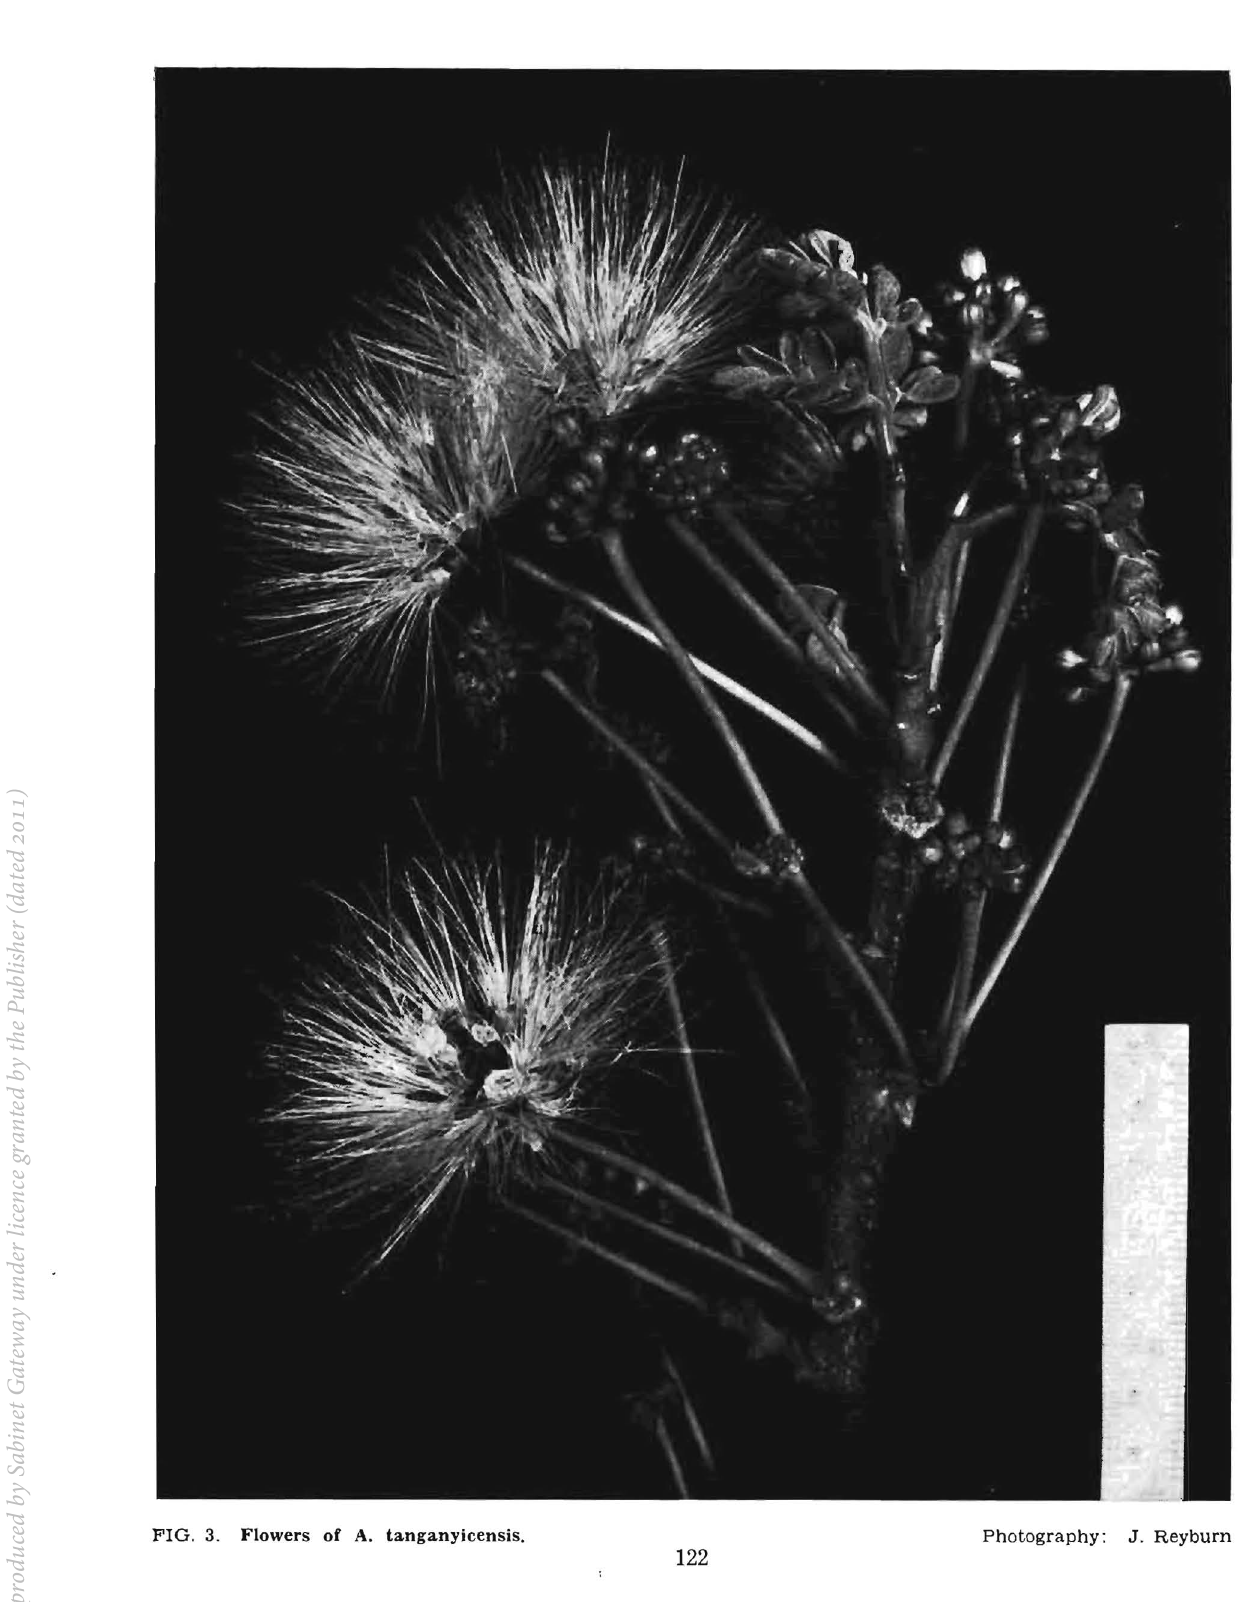
FIG. 3. Flowers of A. tanganyicensis. Photography: J. Reyburn